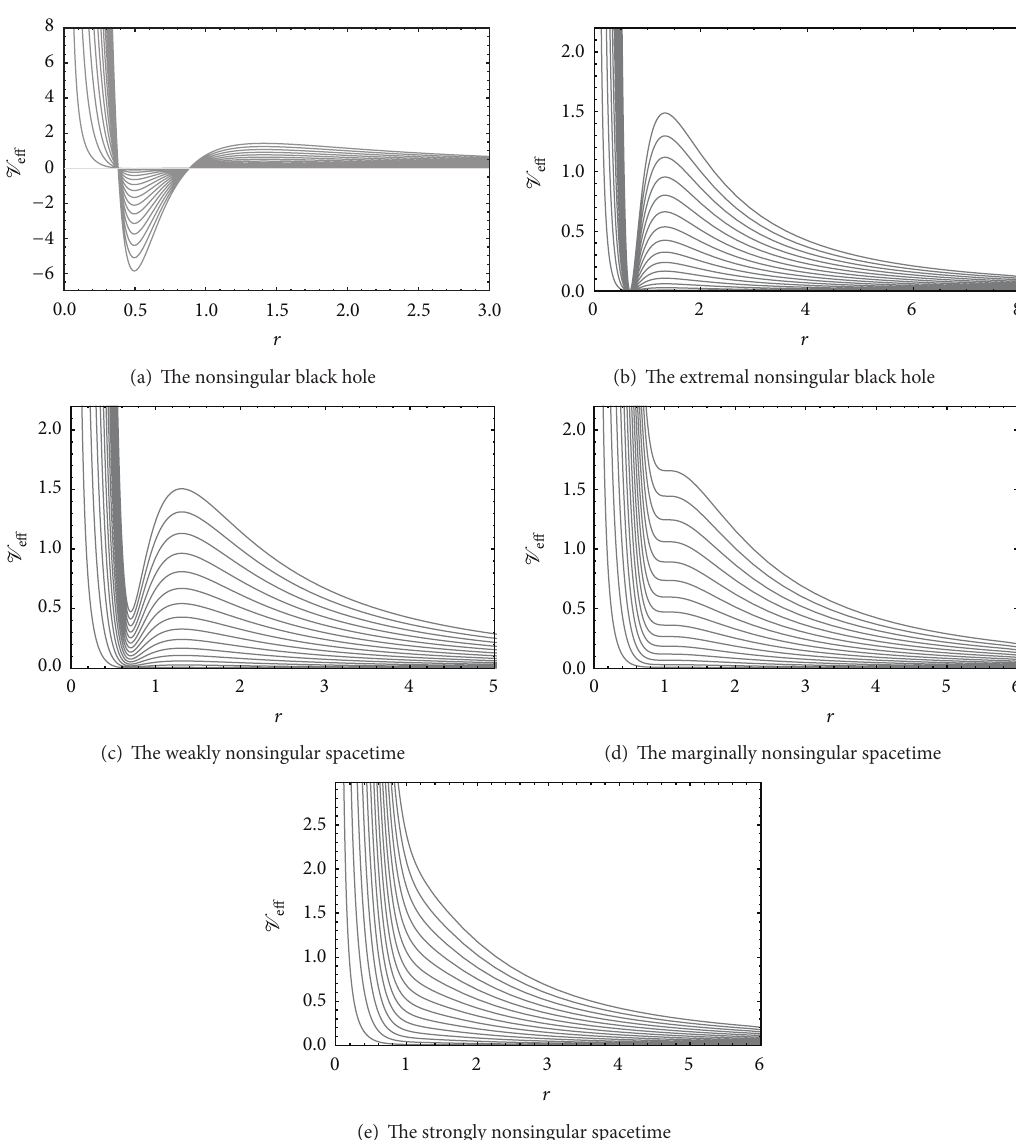
Figure 2: Behavior of the effective potential V